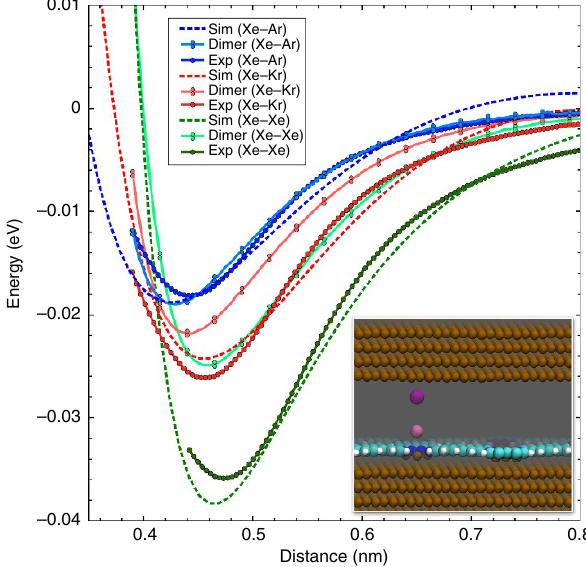
Figure 4 | Theoretical calculation. Comparison of simulated tip–surface and dimer potential energy curves with experimentally derived curves (the same experimental data as in Fig. 3e) for each rare gas atom pair. The z - position of the experimental curves has been normalized with respect to the simulated Xe–Kr tip–surface curve. The curves were fitted with polynomial functions. Inset: atomic snapshot of the simulated tip–surface